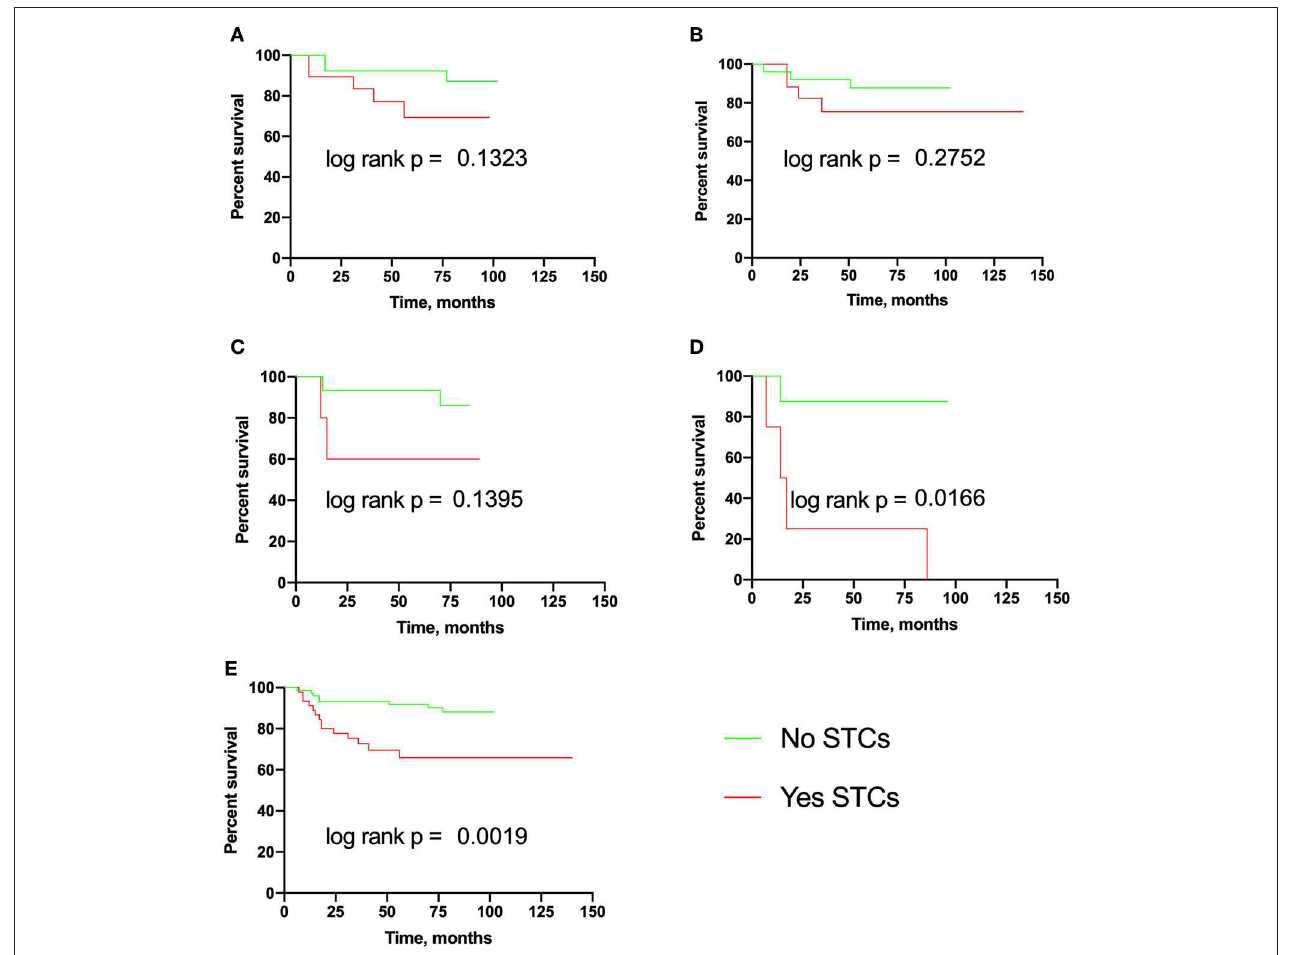
FIGURE 3 | Metastasis-free survival in breast cancer patients with eSTCs. (A) Luminal A. (B) Luminal B. (C) Triple-negative. (D) HER2-positive. (E) Total group.